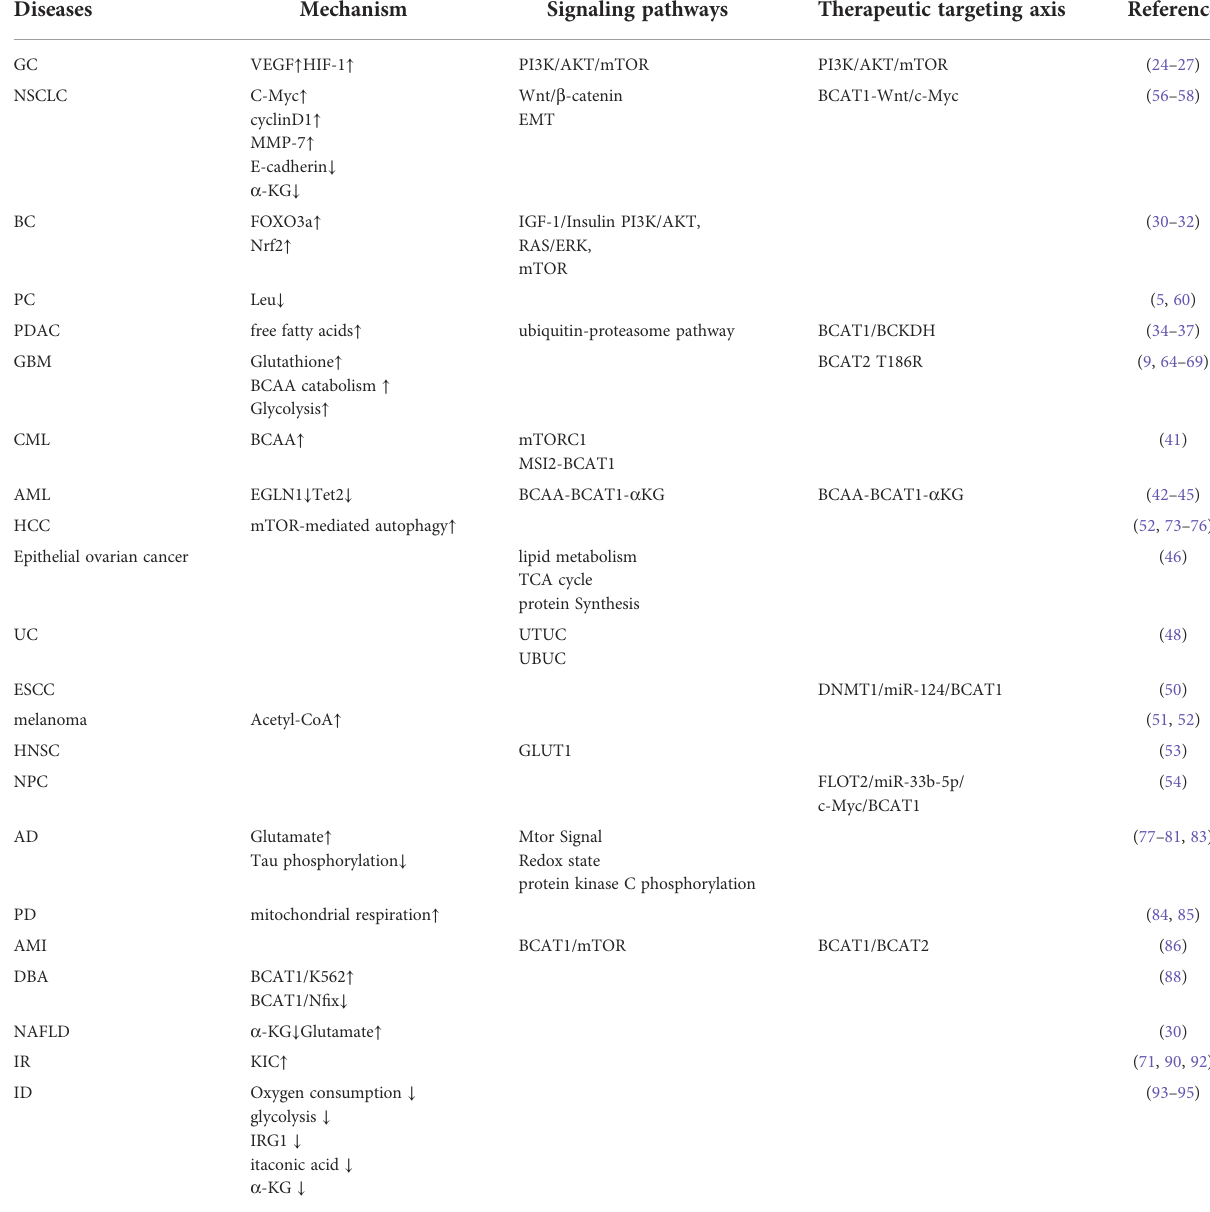
TABLE 1 The mechanism of action, signaling pathway and therapeutic targeting axis of BCAT in these